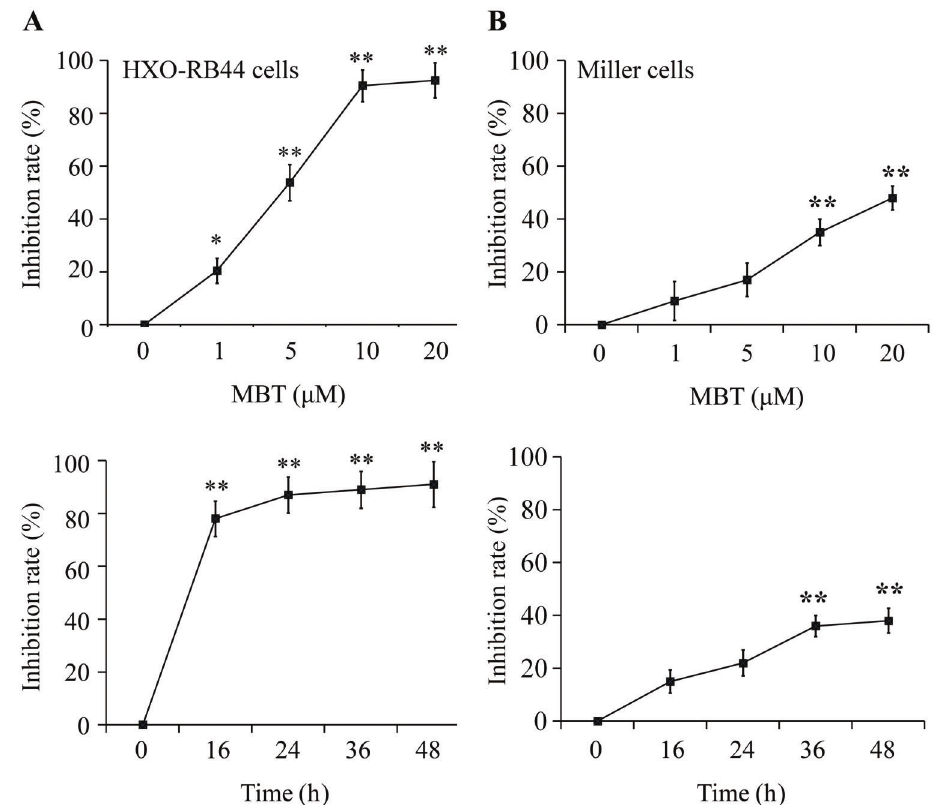
Figure 1. Effects of 2-methyl-2-butanol (MBT) on HXO-RB44 cells ( A ) and Miller cells ( B ) (n=6). Data are reported as means ± SD. *P o 0.05 and **P o 0.01 vs 0 (ANOVA).